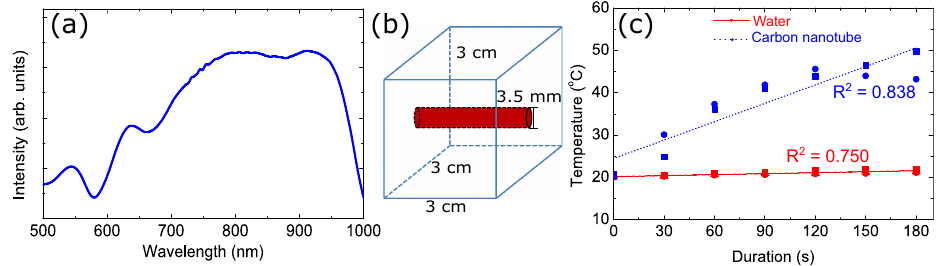
Figure 4. ( a ) The optical absorption of (6,5) SWNT, ( b ) the schematic diagram of the phantom for laser heating experiments, and ( c ) the temperature of the samples as a function of the laser heating